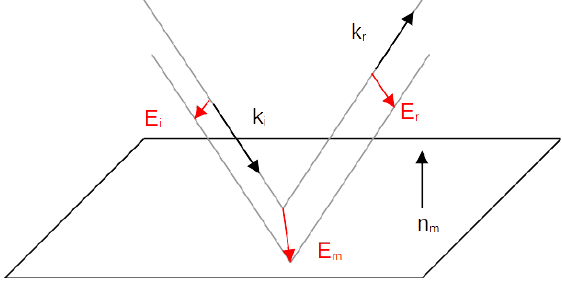
Fig. 4. E-field vectors for a reflection on a flat